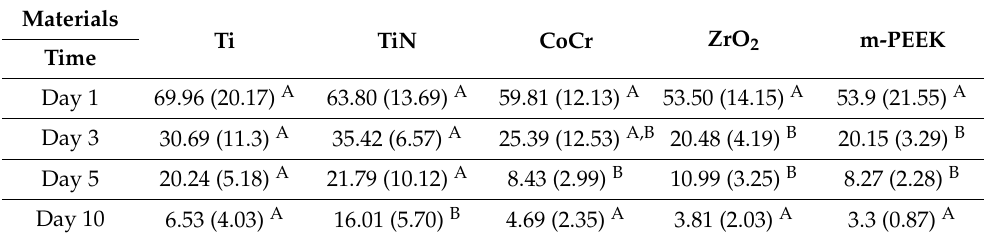
Table 2. The mean and standard deviation values of cell proliferation percentage at days 1, 3, 5, and 10 (HGKC). Values with the same superscript letters represents a non-significant difference (Tukey’s post hoc ( p > 0.05)) between the investigated materials at each time point.